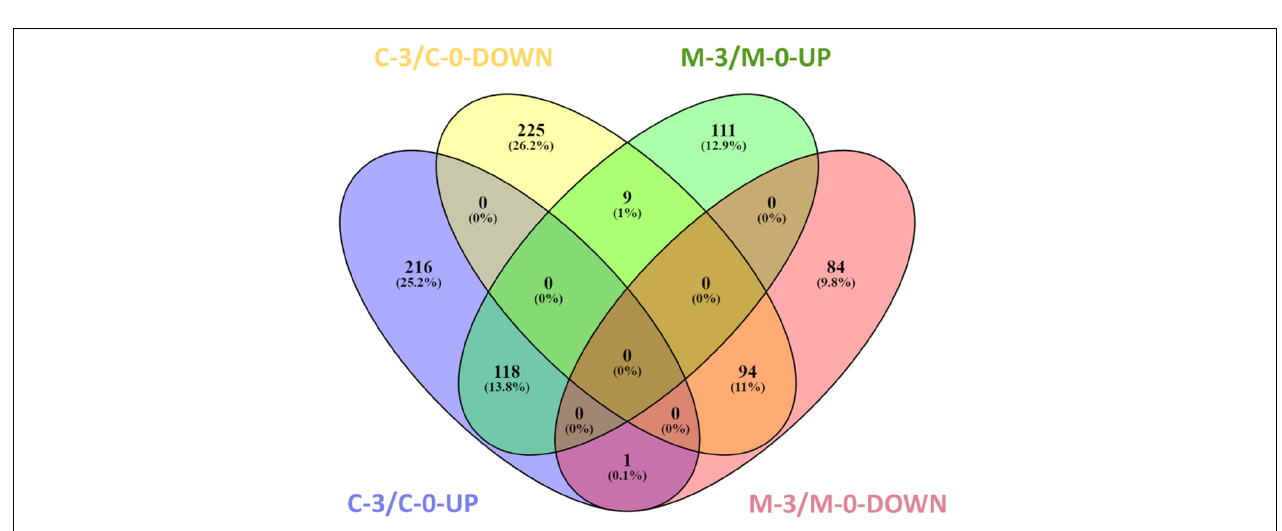
FIGURE 3 | Gene ontology categorization of differentially expressed genes in X. fastidiosa in response to overexpression of mqsR . Genes were classified by functional category of biological processes using Blast2GO. UP: upregulated genes; DOWN: downregulated genes.